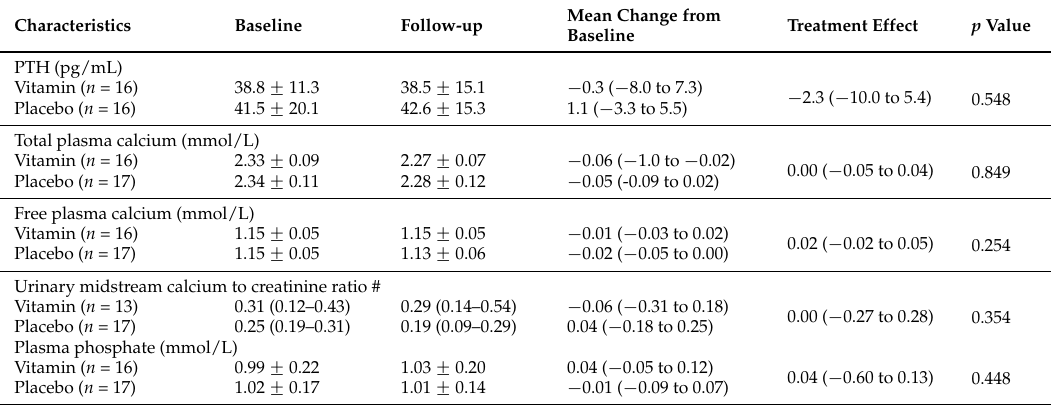
Table 3. Parameters of mineral metabolism at baseline and follow-up, and changes from baseline in study participants with available values at both study